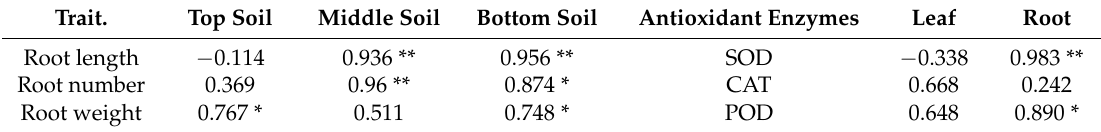
Table 4. Correlation analysis of CTIRDE values with root distribution and antioxidant enzymes. Trait. Top Soil Middle Soil Bottom Soil Antioxidant Enzymes Leaf Root 0.936 ** 0.956 **